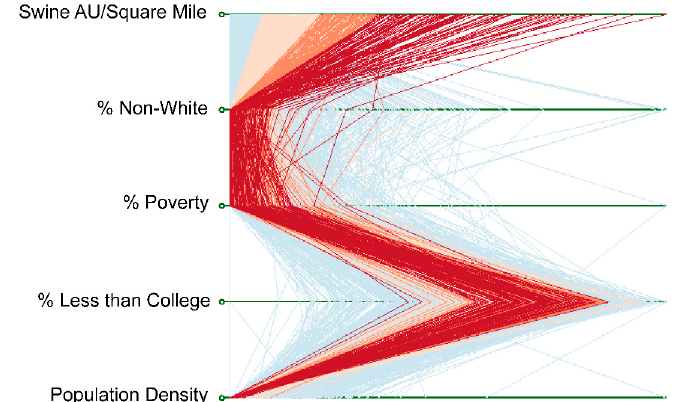
Figure 7. Parallel coordinate plot showing the relationship between Census block group observations of swine AU density and traditional EJ variables, as well as population density. Each line is a CBG. Red and orange lines highlight the characteristics of CBGs with the highest standard deviations of swine densities.